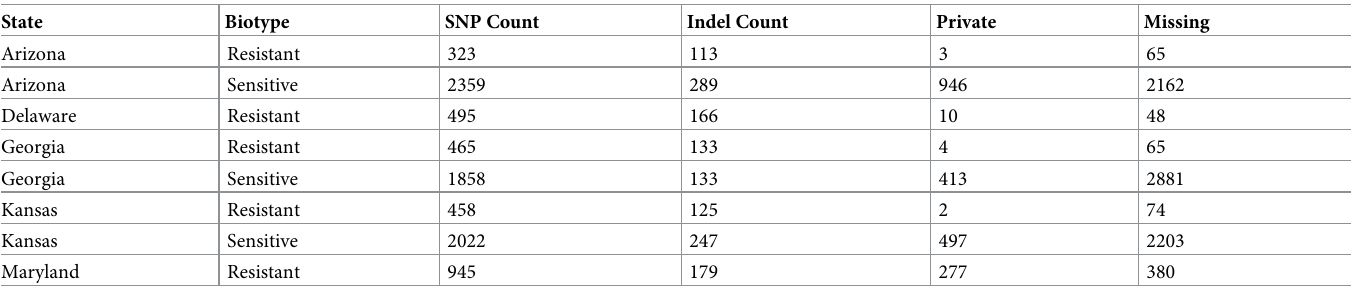
Table 2. Genotyping statistics from WGS reads relative to the EPSPS replicon of GR A . palmeri from Mississippi.